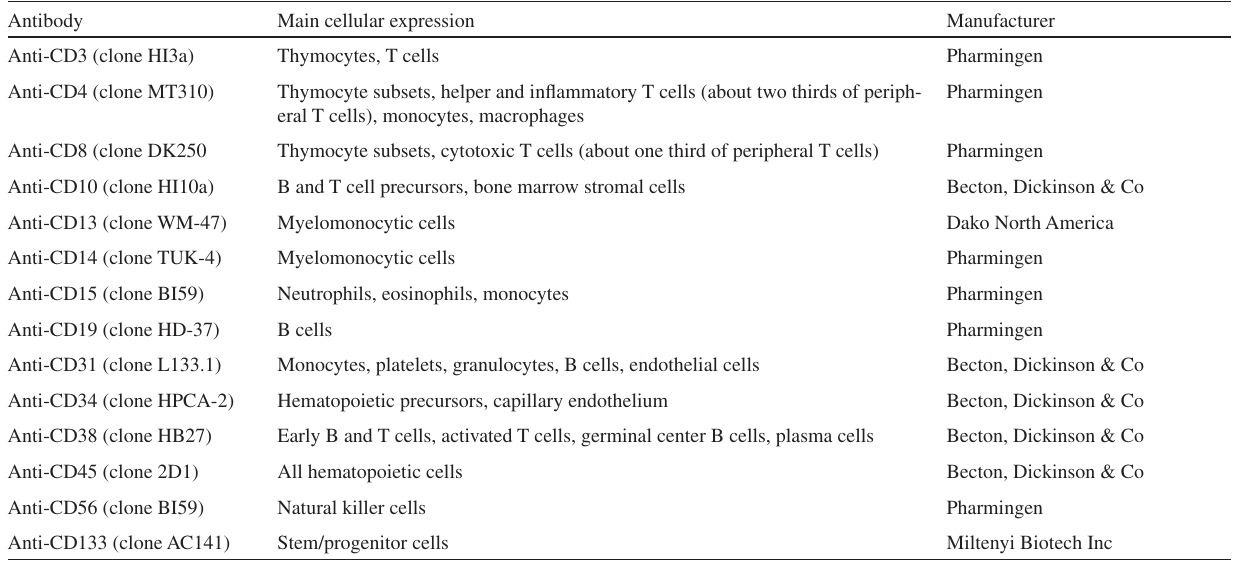
Antibody Main cellular